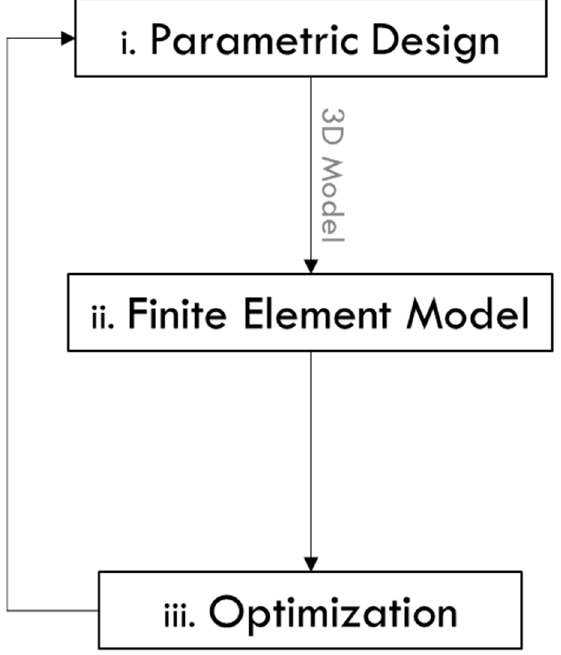
Figure 1. Work fl ow development of the modelling and optimization strategy [10]. Figure 1. Workflow development of the modelling and optimization strategy